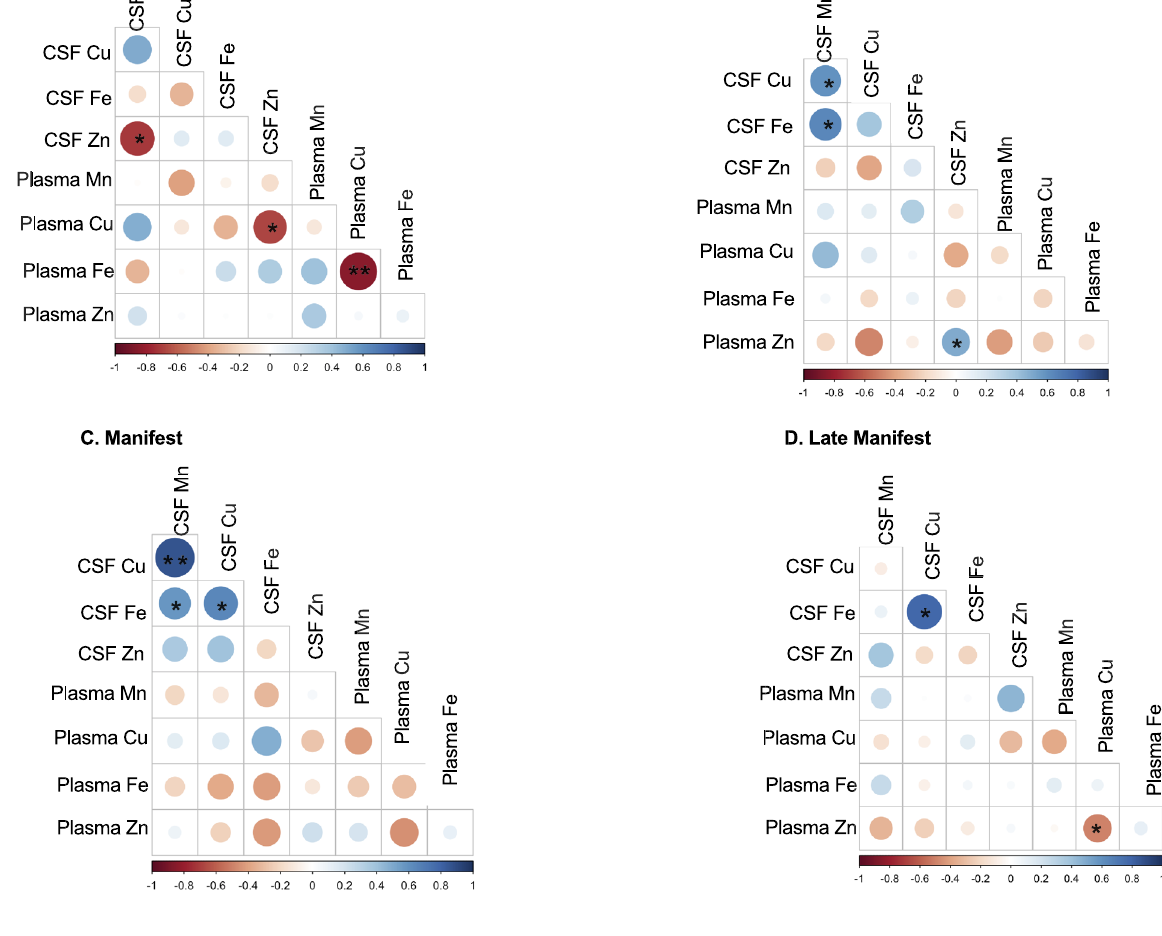
Figure 4. Correlation matrix between CSF and plasma metals in ( A ) Controls, ( B ) Pre-manifest, ( C ) Manifest and ( D ) Late Manifest HD participants. The size and color of the circle indicate the strength and direction of the correlation. Shades of red indicate negative correlations whereas blues indicate positive correlations. An asterisk (*) indicates p < 0.05 and (**) indicates p <